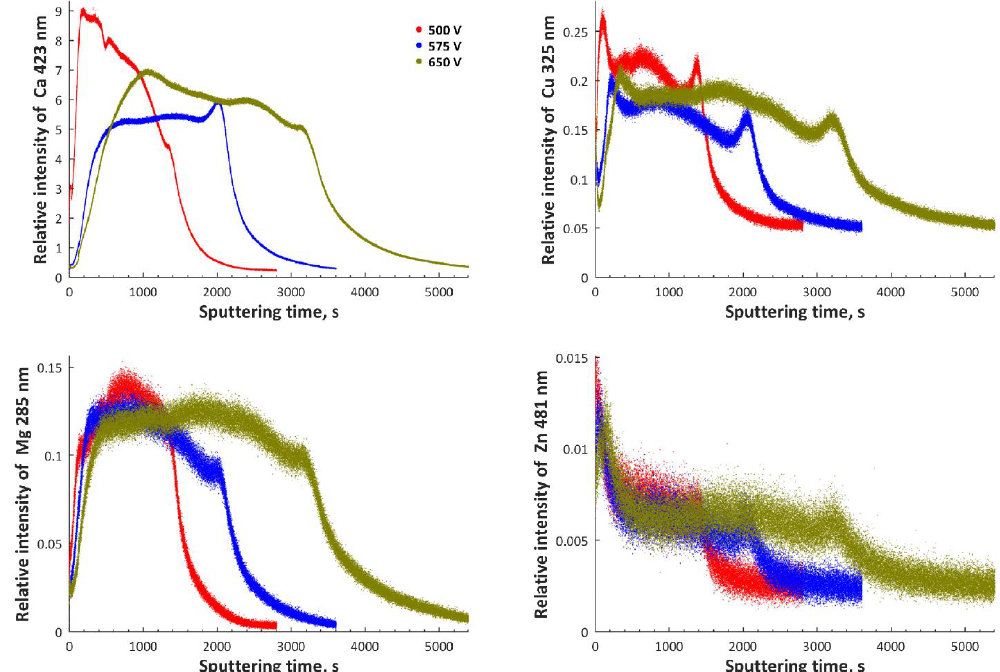
Figure 4. GDEOS (Glow Discharge Optical Emission Spectroscopy) signals of calcium (Ca), magnesium (Mg), copper (Cu) and zinc (Zn) of coatings formed on CP Titanium Grade 2 after PEO process at voltages 500 V DC , 575 V DC , 650 V DC , in 1 L of 85% H 3 PO 4 with the additions of 125 g Ca(NO 3 ) 2 · 4H 2 O, 125 g Mg(NO 3 ) 2 · 6H 2 O, 125 g Zn(NO 3 ) 2 · 6H 2 O, and 125 g Cu(NO 3 ) 2 · 3H 2 O.